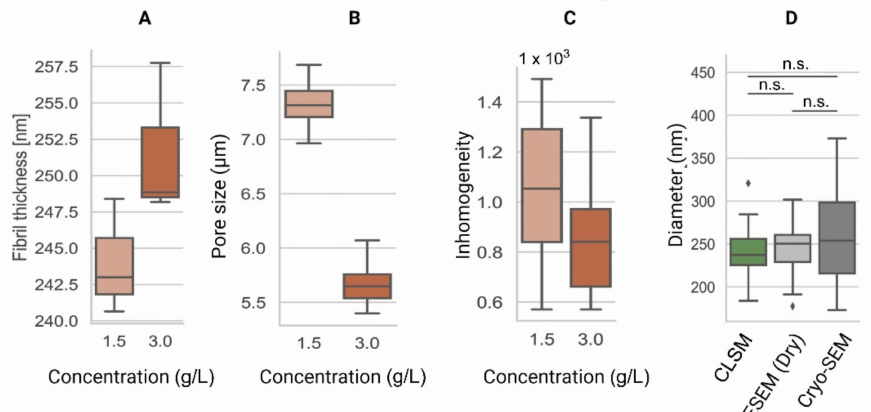
Figure 5. Comparison of the microarchitecture parameters among collagen type-I hydrogels of 1.5 g/L and 3.0 g/L. ( A ) Fiber thickness is an estimation of the 3D cross-sectional diameter of collagen fibers [62]. ( B ) Pore size represents the contiguous 3D space between collagen fibers [42]. ( C ) Inhomogeneity derived from the CLSM data is a measure of local and global variance in the pore size [57]. ( D ) Comparison of pore diameters among CLSM [42], ESEM, and Cryo-SEM images of collagen type-I hydrogels (3.0 g/L). These data indicate similar fiber diameter results among all techniques. Data shown in box-and-whisker plots indicating the median, first and third quartiles as boxes, variability as whiskers and outliers shown as ˛ . n.s. = no significant